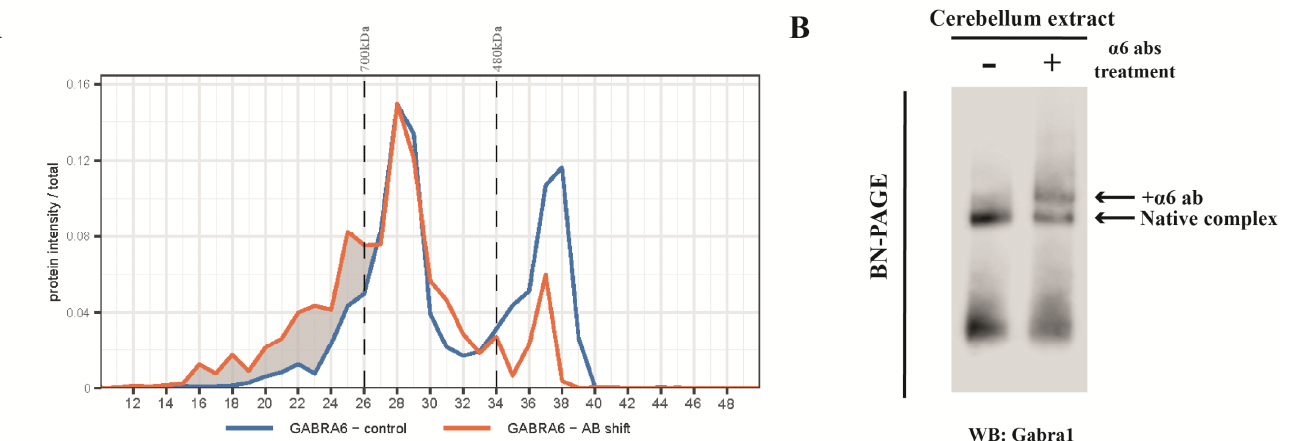
dant original peptides profiles (raw data); middle panel: intensity rowsum rescaled peptides pro-